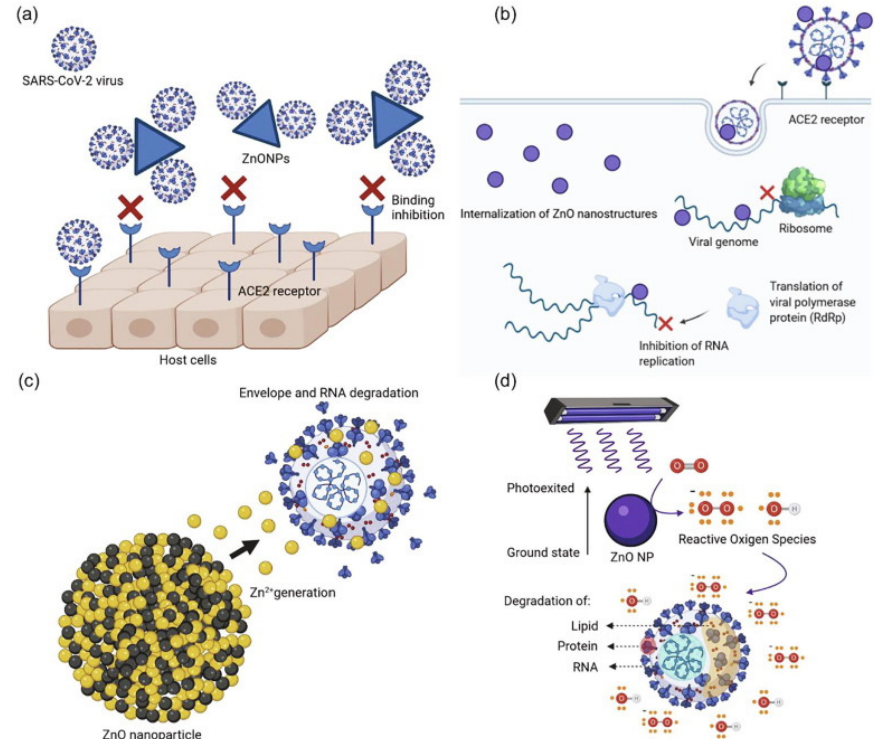
Figure 7. Possible mechanisms of antiviral activity of ZnO against SARS-CoV-2. ( a ) Design of ZnO nanostructures for the possible anchoring of SARS-CoV-2 virions, thus inhibiting interactions with host cell receptors. ( b ) Internalization of ZnO nanostructures for the inhibition of early stages of the viral replication cycle. ( c ) Ion release as a surface attack mechanism to disrupt the plasmid and RNA virus integrity. ( d ) Photocatalytic generation of reactive oxygen species for the possible degradation of the lipid, protein, and nucleic structure of SARS-CoV-2. Reproduced from [155]; article distributed under the terms of the Creative Commons CC-BY license.